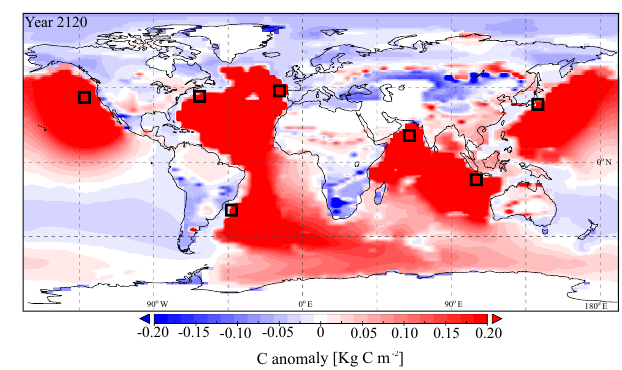
Figure 1. Absolute changes in oceanic and land carbon between I- 3000 and the RCP 8.5 control run (I-3000 simulation minus RCP 8.5 control run) at the end of the injection period (year 2120). The black rectangles represent the locations of the seven injection sites, where the injections occurred in the center of the black